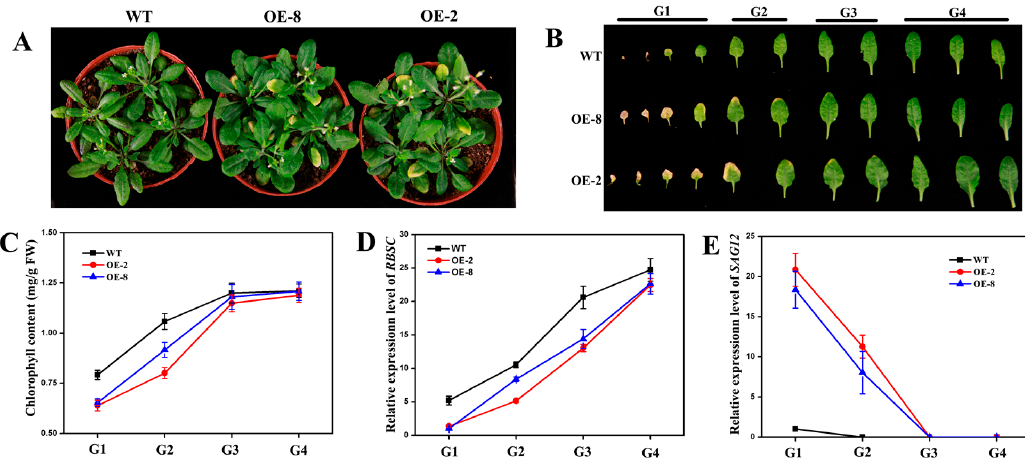
Figure 7. Precocious senescence phenotypes of the detached leaves from CmNAC60 overexpressing plants after dark-treated for five days. ( A ) Fully expanded rosette leaves of the six-week-old Arabidopsis plants were excised and dark-treated for five days. Pictures were taken at zero and five days after dark treatment. ( B – E ) Chlorophyll content ( B ), relative expression levels of RBSC ( C ) , SAG12 ( D ), and CmNAC60 ( E ) in the detached leaves after being dark-treated for five days. The experiments were independently repeated three times, and 12 leaves were used for each replicate. Data are mean ± SD from three biological replicates. Different lowercase letters indicate statistically significant differences at p < 0.05. Bars indicate standard deviation.